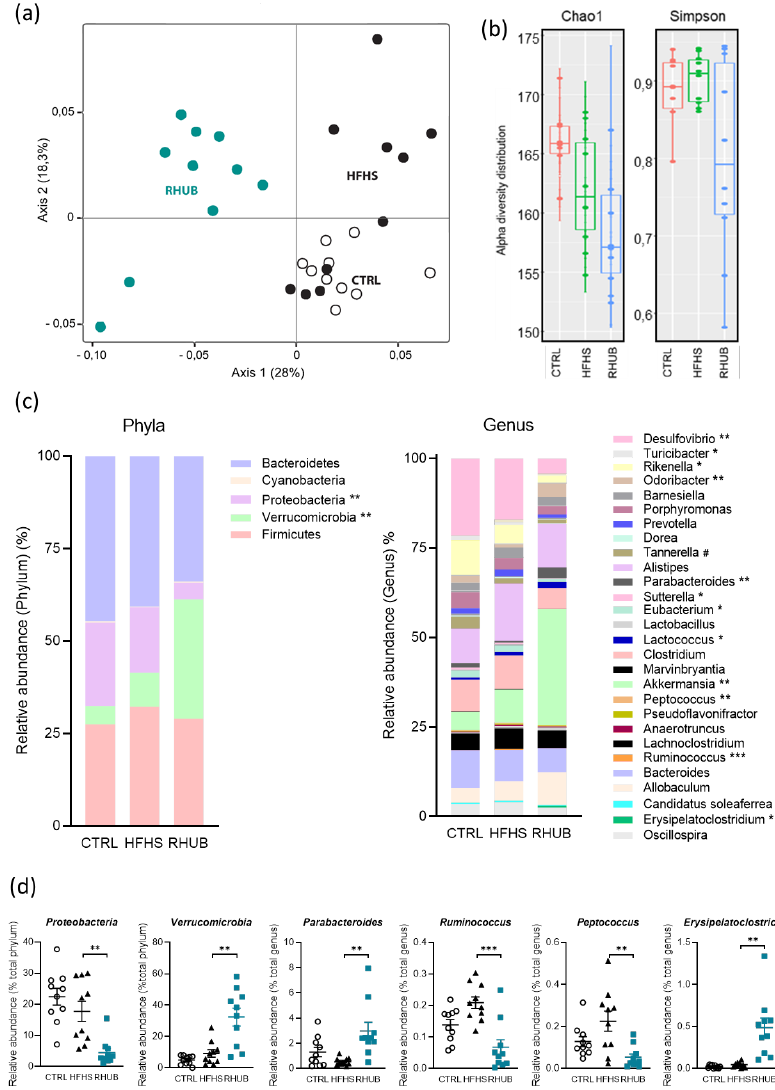
Figure 5. Effects of rhubarb root extract on gut microbiota composition ( a ) Non-metric Figure5. Effectsofrhubarbrootextractongutmicrobiotacomposition( a )Non-metricmultidimensional multidimensional scaling (MDS) representing the Jaccard-binary differences between individuals scaling (MDS) representing the Jaccard-binary differences between individuals within each within each group. ( b ) Bacterial α -diversity from fecal microbiota. Bacterial richness (Chao1 index) is shown on the left; bacterial evenness (Simpson index) is shown on the right. ( c ) Relative abundance obtained by OTUs of the major bacterial phyla (left) and genera (right). ( d ) Relative abundance of specific bacterial phyla and genera in each sample among the CTRL, HFHS and RHUB group. ( c , d )